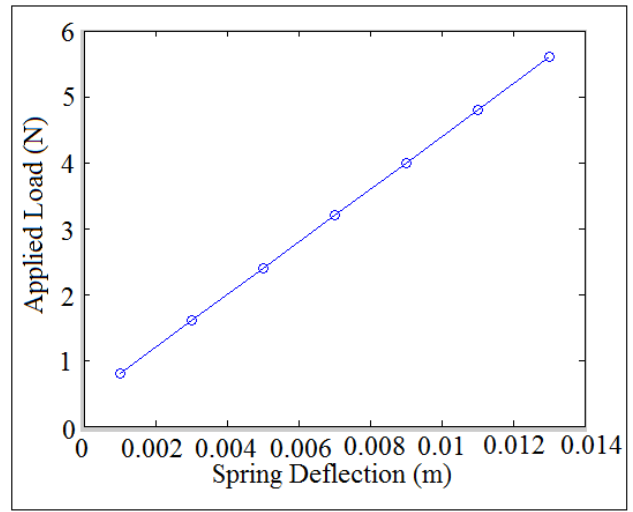
Figure 2. Applied load against spring deflection.